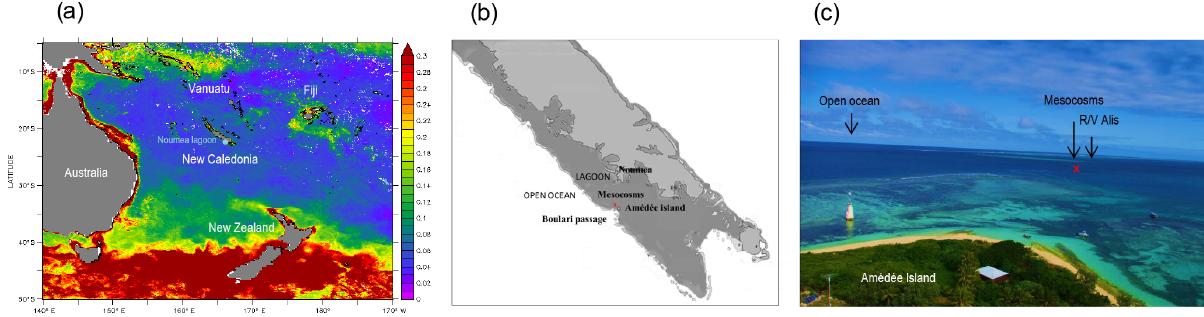
Figure 3. Location of the study site of the VAHINE experiment. Panel (a) : map showing surface chlorophyll a concentrations (Moderate Resolution Imaging Spectroradiometer, MODIS) in the south-western Pacific during the study period (January–February 2013); panel (b) : map of the Noumea lagoon; panel (c) : a view taken from Amédée Island showing the location of mesocosms and R/V Alis